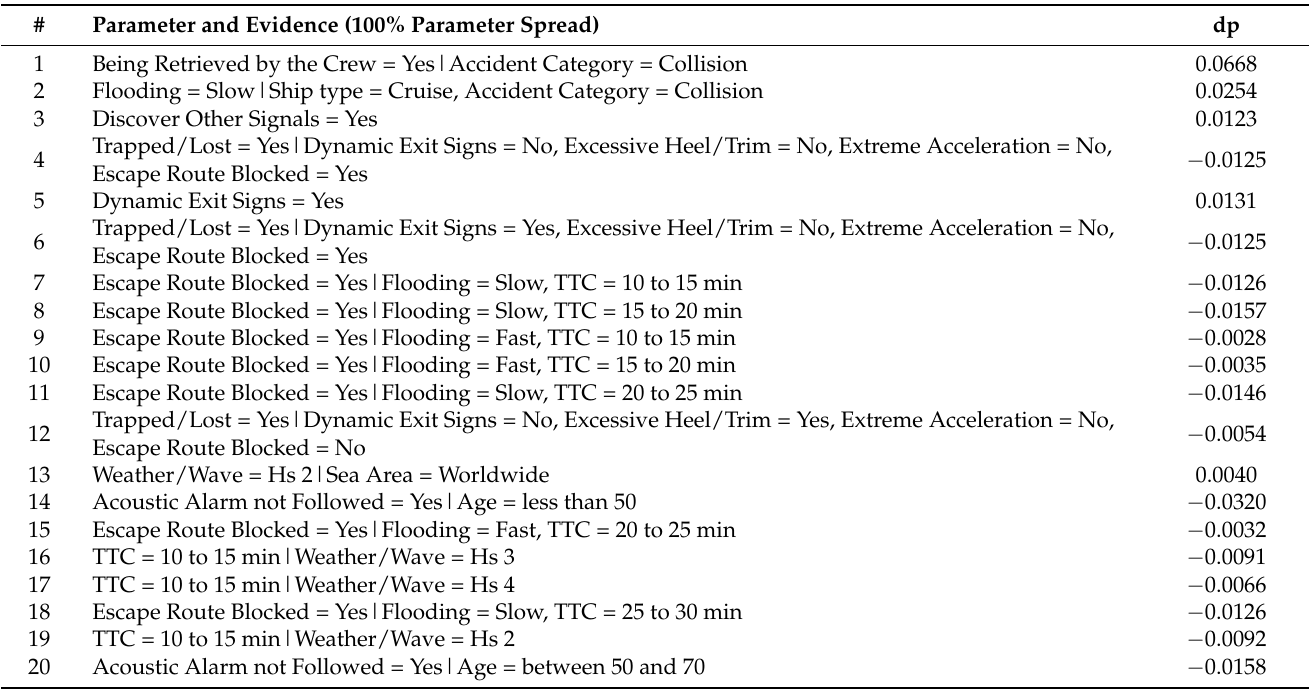
Table 4. Results for ∆ R (lives saved per ship/lifetime) for the RCO considered, per accident type and in